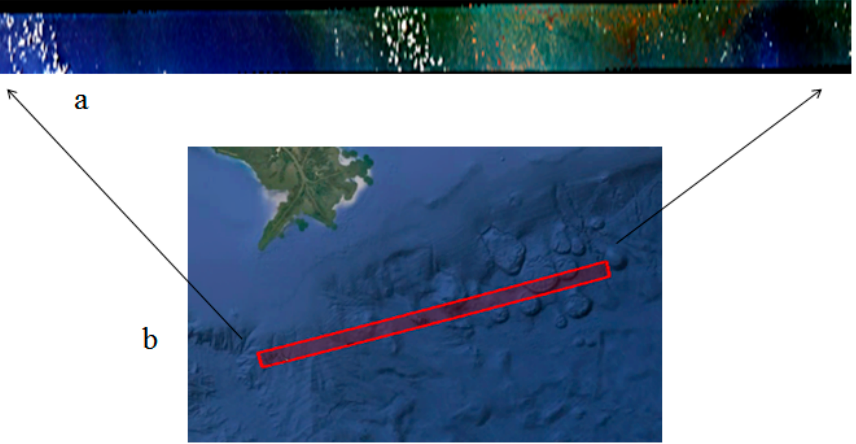
Figure 1. Picture ( a ) is the experimental data image, false-color composite with bands R: 678 nm, G: 540 nm, and B: 443 nm. Picture ( b ) is study area scope was obtained via ENVI and Google Earth software.